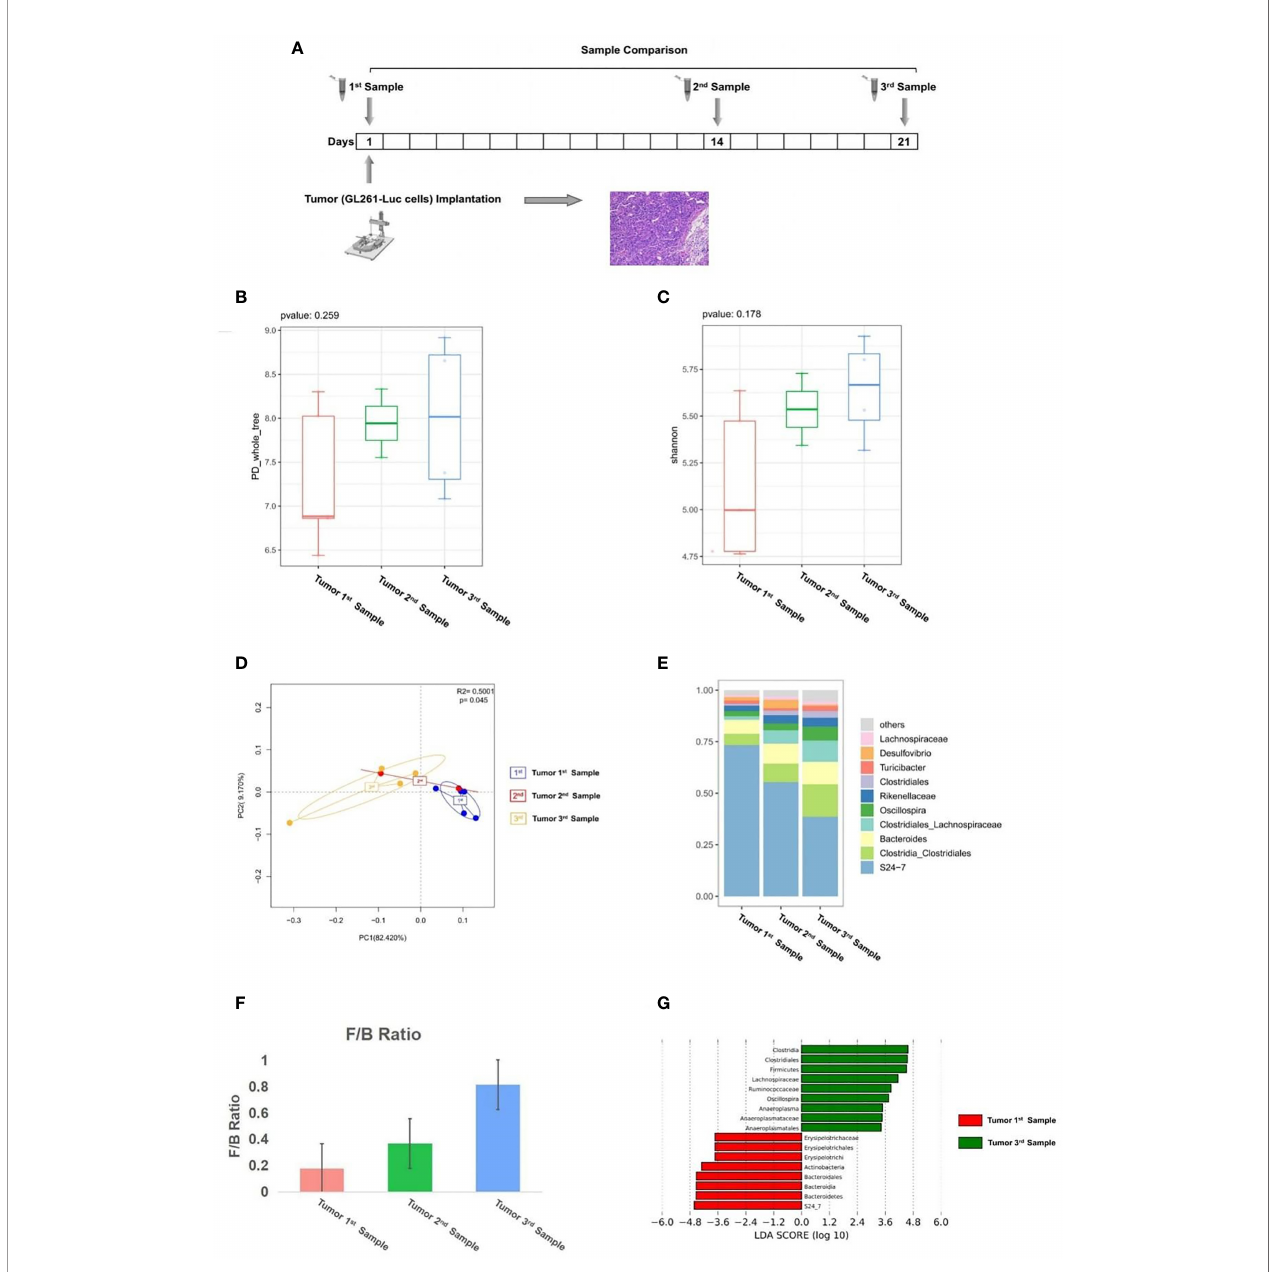
FIGURE 1 | (A) Experimental design and stool sample collection ( fi rst part). (B – G) Glioma growth induced structural changes of gut microbiome in mice. Comparison of tumor 1st to 3rd samples (n = 5). (B) The PD_whole_tree alpha diversity index. (C) The Shannon alpha diversity index. (D) PCoA plot of b -diversity. (E) Taxa analysis. (F) Firmicutes to Bacteroides ratio. (G) Bar plot of LDA score from LEfSe